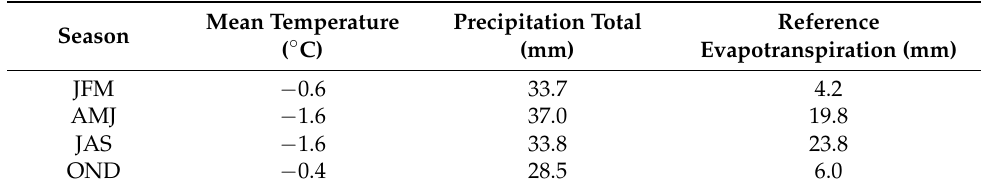
Table 5. Mean differences in meteorological inputs between MS5 (ERA5-Land) and MS4 (CHMI data) for JFM, AMJ, JAS, and OND in the Czech Republic during the 1981–2020 period. Mean Temperature Precipitation Total Reference Season ( ◦ C) (mm) Evapotranspiration (mm) JFM − 0.6 33.7 4.2 AMJ − 1.6 37.0 19.8 JAS − 1.6 33.8 23.8 OND − 0.4 28.5